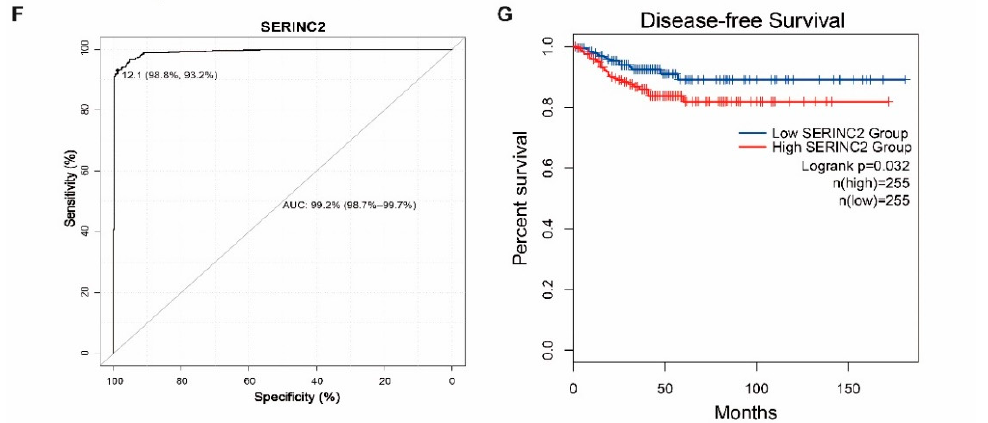
Figure 4. SERINC2 is up-regulated in thyroid cancer. ( A ) The intersection of metabolism pathway related genes and all the differentially expressed genes on the left, and the intersection of metabolism pathway related genes and the selected genes with significant differential methylation and expression from the methylation profile and transcriptome profile of PTC on the right. ( B ) Chronos dependence scores of CYP1B1, DIO1, FABP3 and SERINC2 by CRISPR-Cas9 screening from Depmap in cell lines derived from different organs. ( C ) Expression of SERINC2 in different thyroid cancer cell lines. ( D ) Expression analysis using GEPIA2 shows SERINC2 is up-regulated in thyroid cancer tissue. ( E ) Representative immunohistochemical pictures of PTC and adjacent tissues (400 × ). ( F ) ROC analysis of SERINC2 expression in thyroid cancer from TCGA and GTEx databases. ( G ) Survival